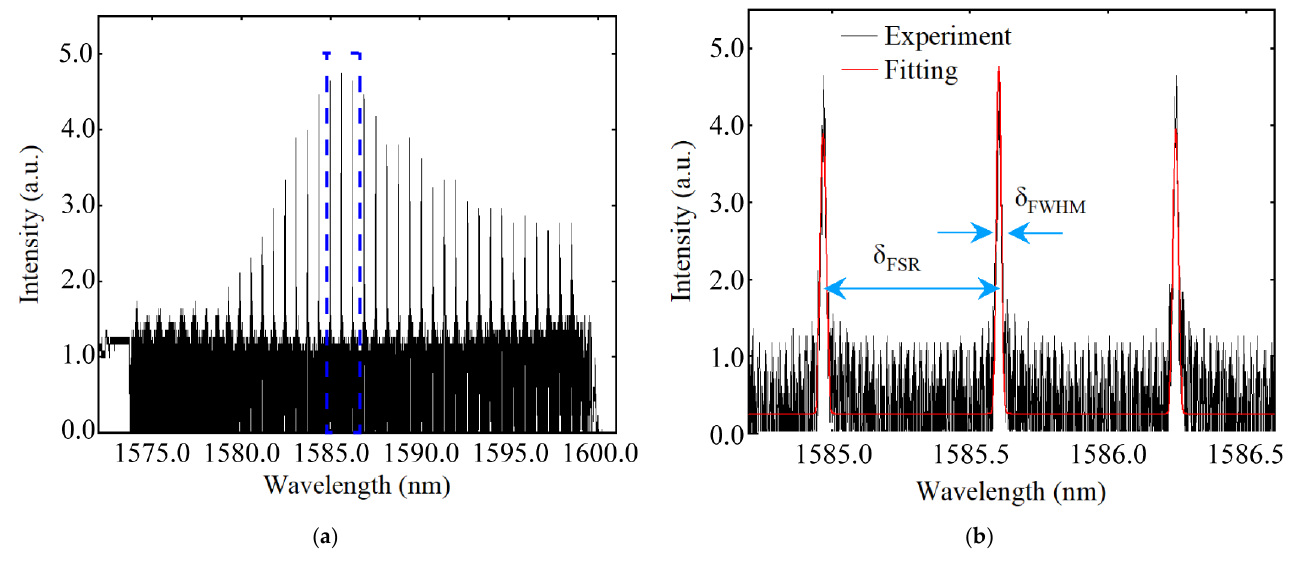
Figure 7. The transmission power spectrum of the F-P cavity. ( a ) The transmission power spectrum of the F-P cavity ranging from 1572 nm – 1601 nm when the output power of the tunable laser is 1 mW. The measured FSR is 0.647; ( b ) The partial transmission power spectrum and its fitted curve range from 1584.7 nm to 1586.6 nm. The measured f R is 38 when the measured FWHM is 0.017 near 1585 nm.